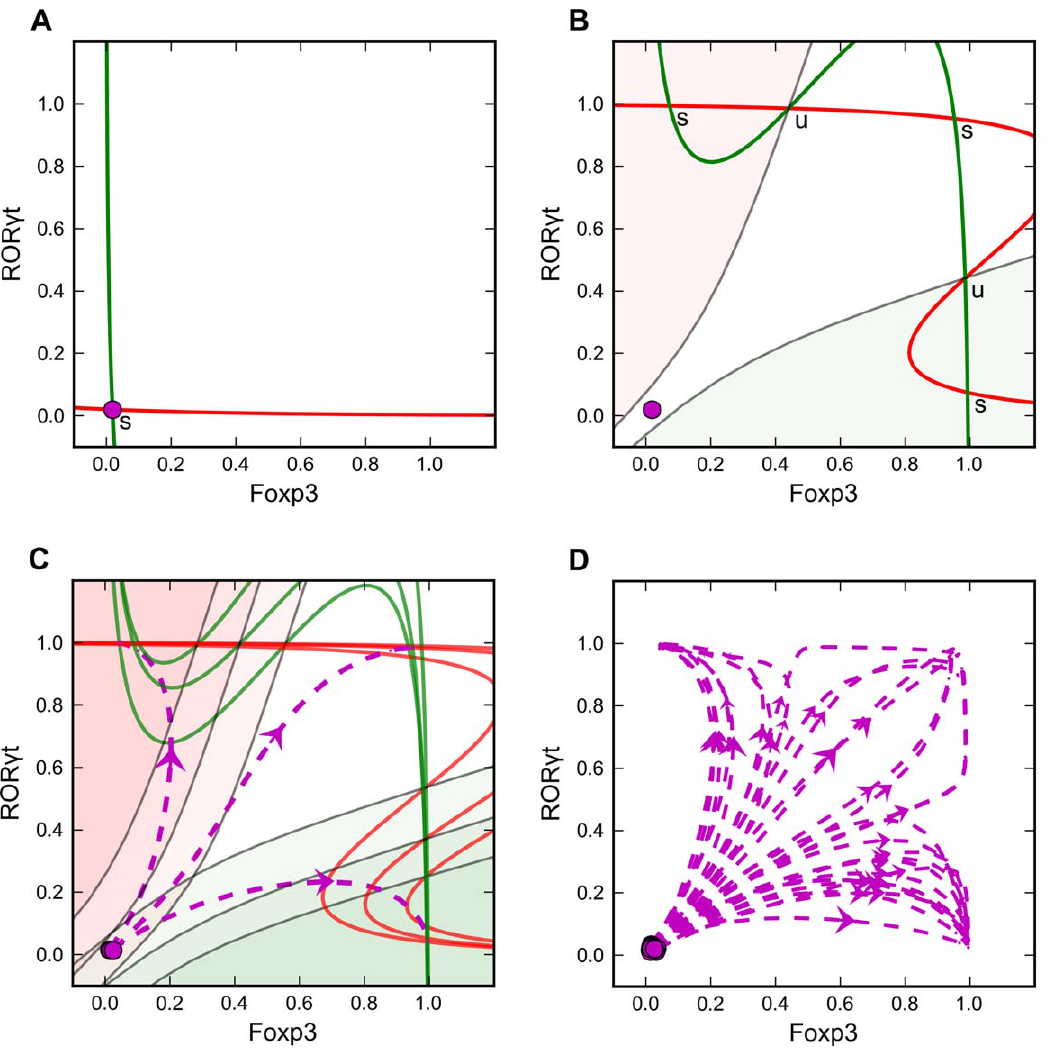
Figure 3. Phase plane analysis of the symmetrical model without intermediates. X and Y axes: dimensionless quantities that represent the intracellular concentrations of master regulators Foxp3 and ROR c t respectively. Value=1 indicates the maximum intracellular concentration of the master regulator, and value=0 indicates the absence of the master regulator. Red Line: nullcline for ROR c t. Green line: nullcline for Foxp3. Steady states, at the intersections of red and green nullclines, are labeled as ‘u’ (unstable) or ‘s’ (stable). Magenta dashed line with arrow: trajectory of a time- course simulation. Semi-transparent red and green areas: the basins of attractions for ROR c t high Foxp3 low and ROR c t low Foxp3 high states, respectively. A. Phase plane for the average cell with [TGF- b ]=0. Magenta circle: ROR c low Foxp3 low steady state. B. Phase plane for the average cell with [TGF- b ]=0.5 units. Magenta circle is the location of the steady state in Panel A. C. Overlaid phase planes and trajectories for three cells adopting distinct fates. D. Simulation trajectories for a population of 30 cells on the plane of ROR c t and